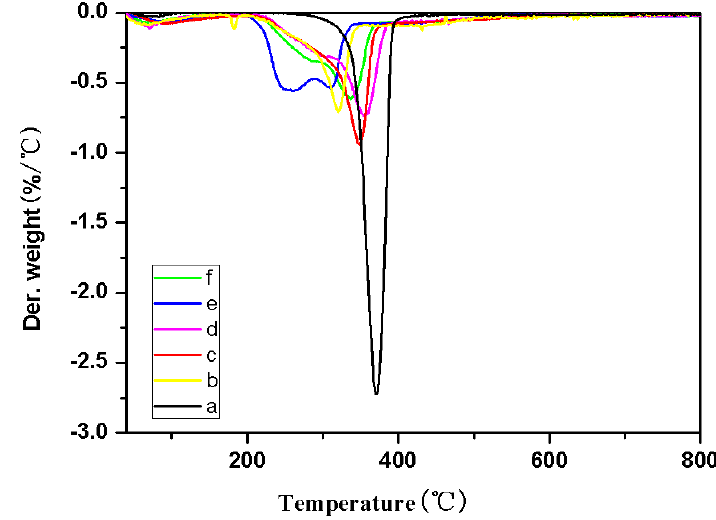
Figure 5. TG curves of cellulose (a), cellulose-COOZn (b), cellulose-COOMg (c), cellulose-COOCa (d), cellulose-COONa (e), and cellulose-COOBa (f) under N 2.